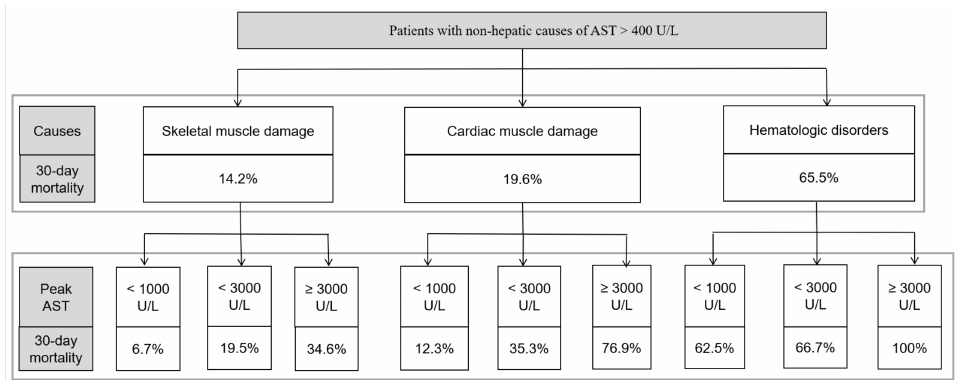
Figure 4. Simplified algorithm based on etiologies and peak